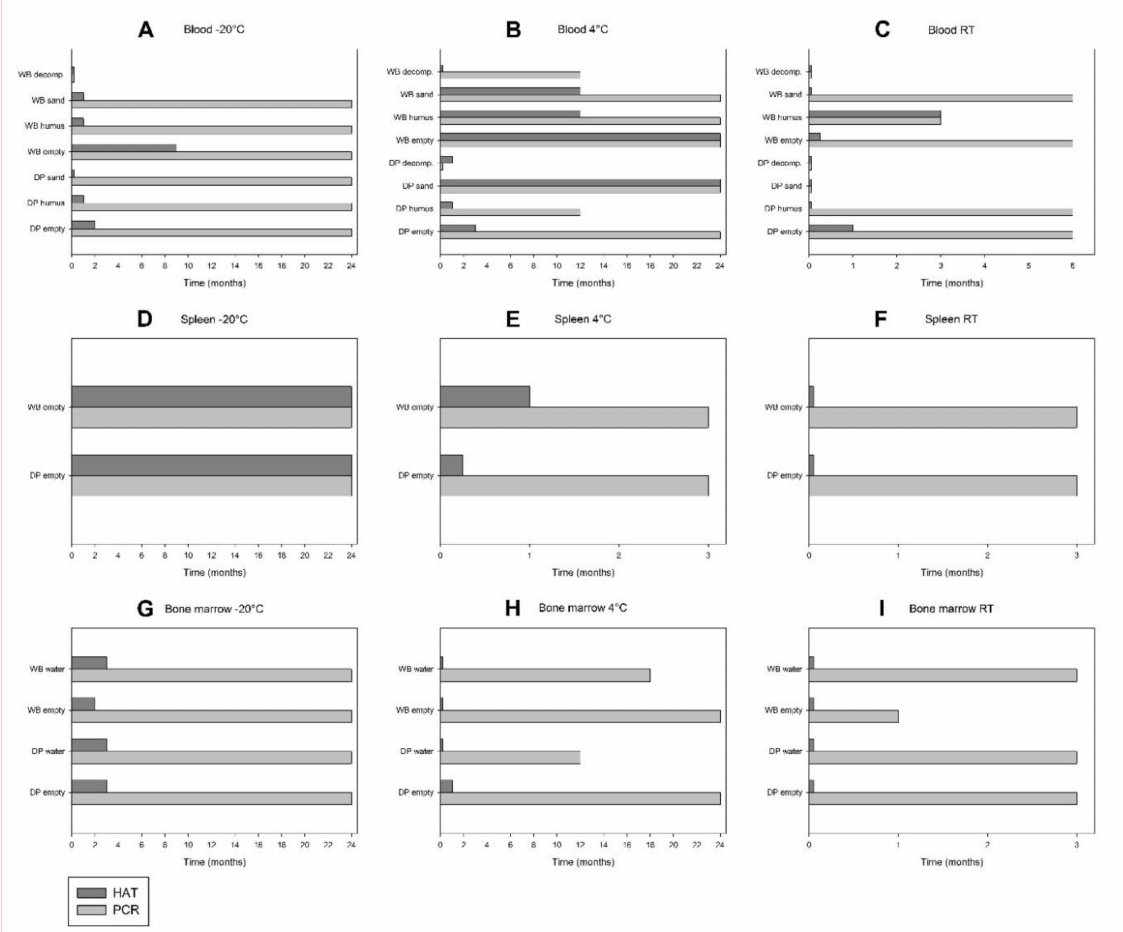
Figure 2. Comparison between qPCR and HAT results for blood ( A – C ), spleen ( D – F ) and bone marrow ( G – I ) of domestic pigs (DP) and wild boar (WB) during storage in empty boxes or on di ff erent matrices (humus, sand, decomposition island [decomp.], waste, water) at − 20 ◦ C, 4 ◦ C and room temperature